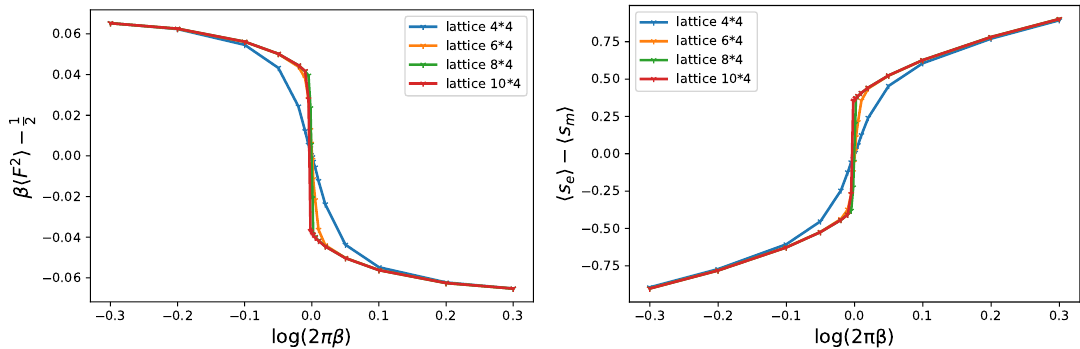
Figure 5 . The gauge field order parameter (lhs.) and the matter order parameter (rhs.) as a function of the rescaled gauge coupling ln(2 πβ ) , for values across the self-dual value β ∗ ≡ 1 / 2 π . The matter field coupling is set to J = 0 . 6